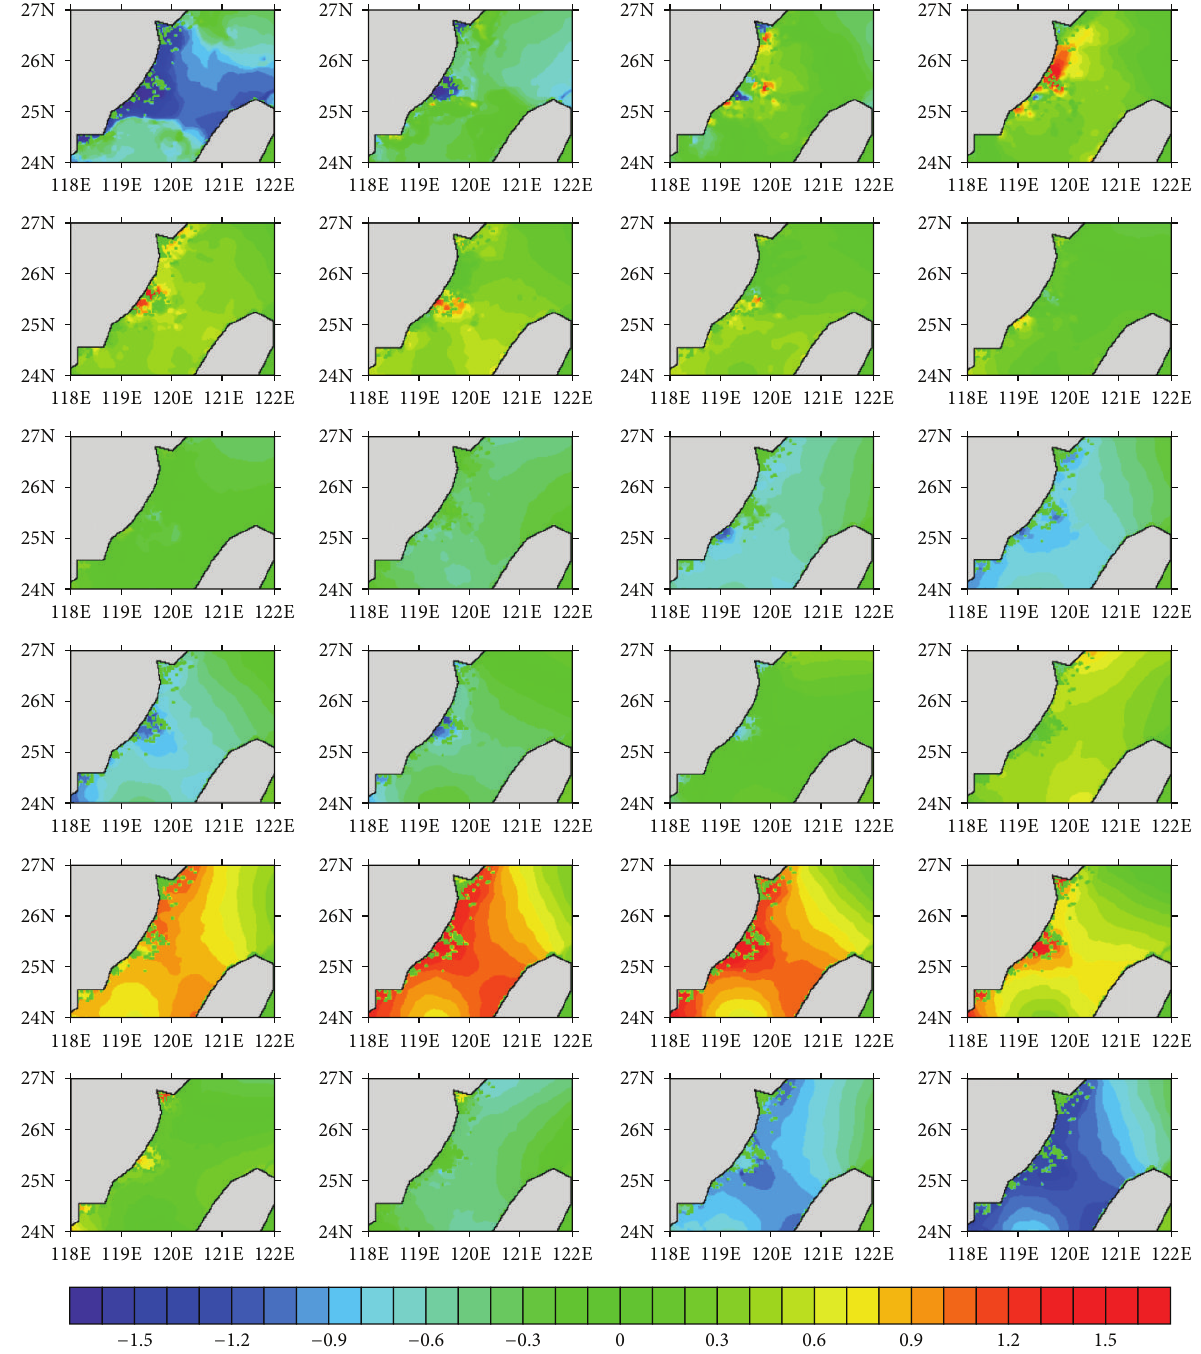
Figure 2: Sea level series in July 13, 2013; output from Experiment 1 which is forced by CCMP multiyear mean winds. (Units: m; from left to right and from top to bottom, the plot, resp., presents the situation of 1, 2, 3, ... ,24 o’clock.)